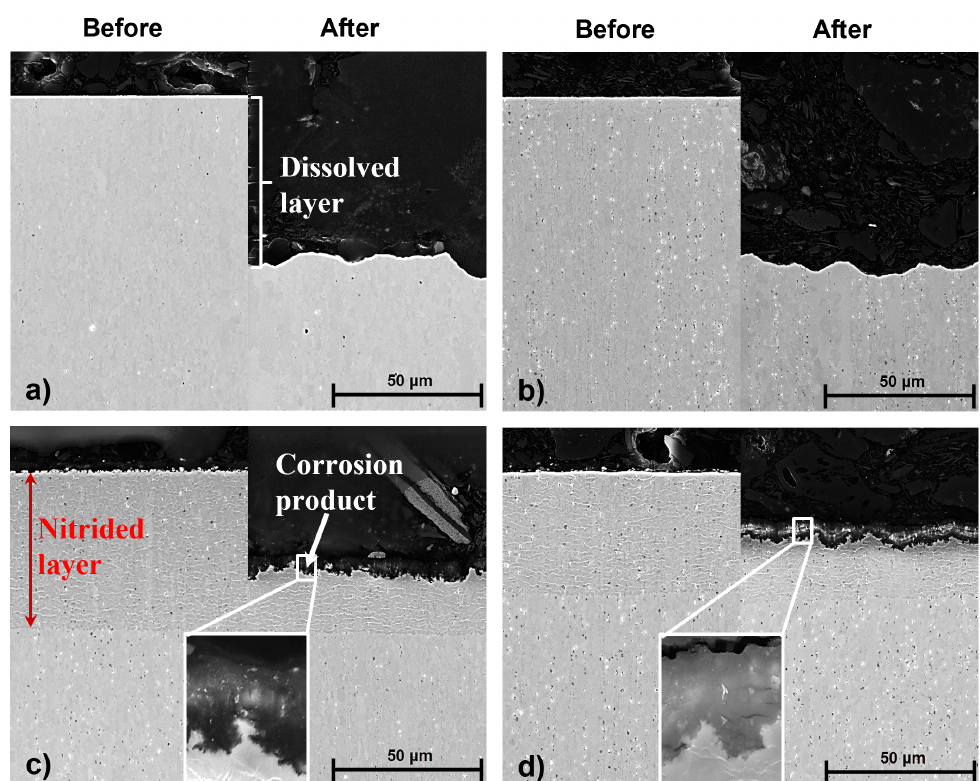
Figure 8. The cross-section samples’ images after immersion in 0.25 M H 2 SO 4 for 24 h: ( a ) untreated, ( b ) f N2 = 0.1, ( c ) 0.5 and ( d ) 0.7. Table 4. Chemical composition (at.%) of corrosion products analysed by EDS on the surface. Element Chemical (at.%) Sample Fe Al O N S Untreated 64.2 14.6 f N2 =